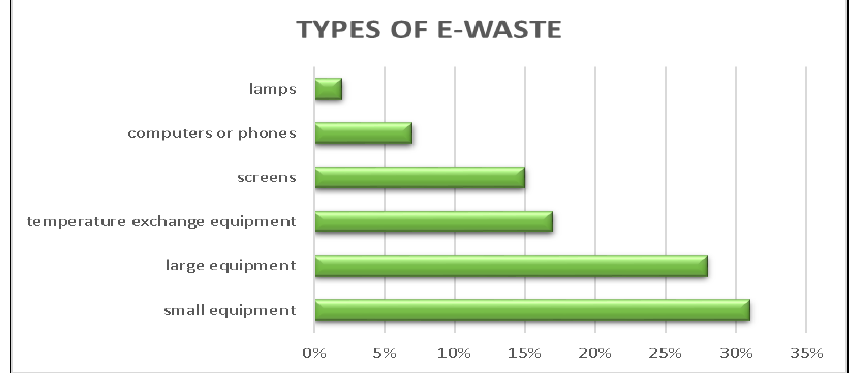
Figure.2. Types of